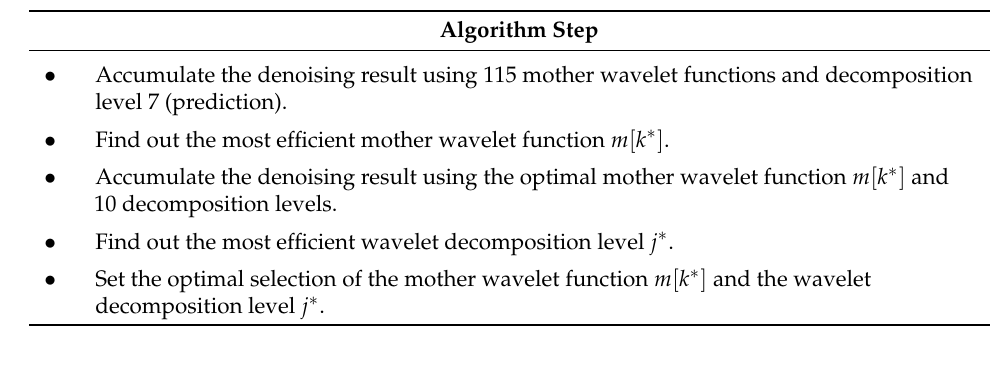
Table 2. The table of algorithm step for the analysis process of the optimal selection.